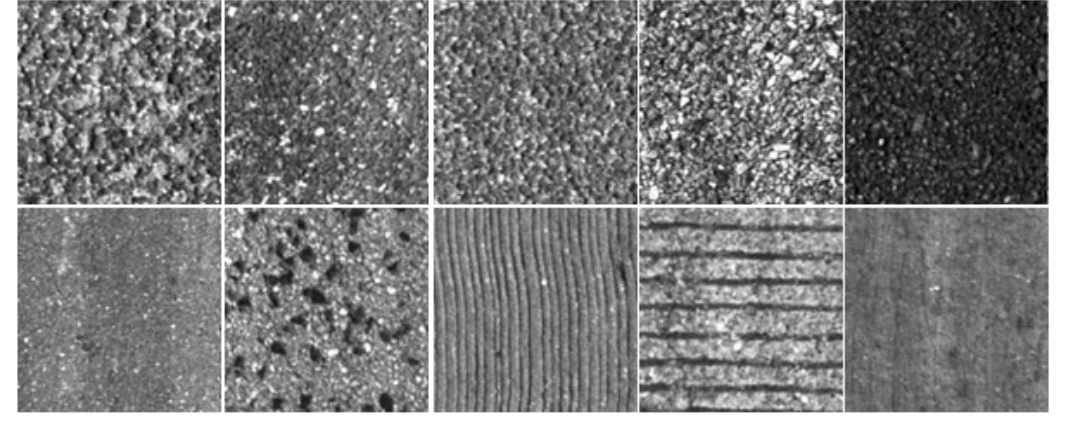
A set of up to 20 square sub-regions of 256 × 256 pixels size are used to perform the classification by majority voting decision. Sub-regions must be placed in the central columns of the image and avoiding the use of pixels masked as non-crack